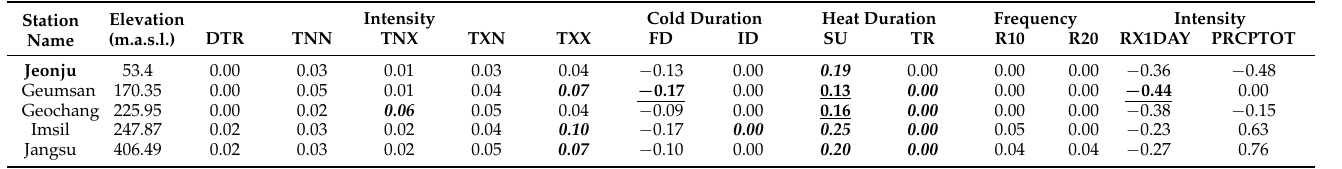
Table A3. Trend magnitudes during spring season (MAM) in the UGRB for 33 years (1988–2020).